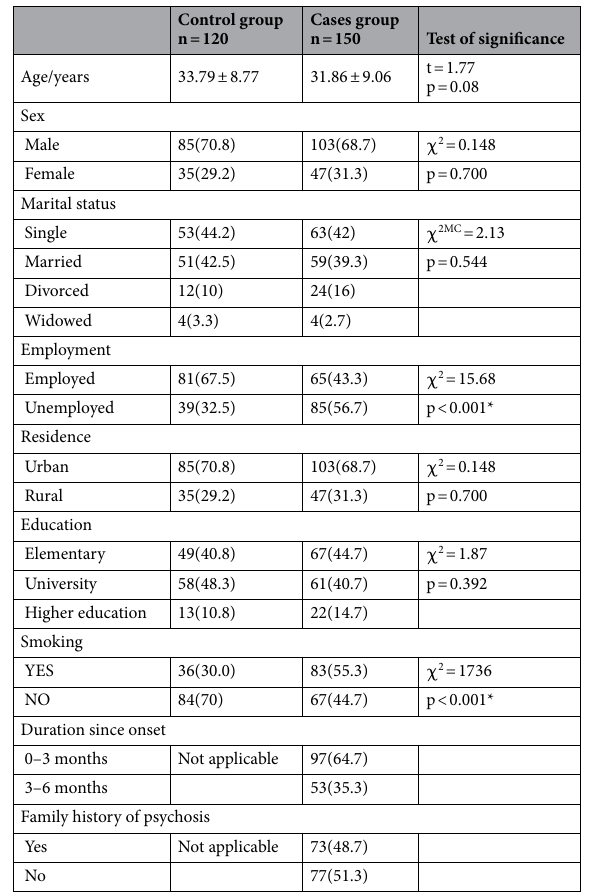
Table 1. Comparison of sociodemographic and clinical characteristics between studied groups. t: Student t test χ 2 = Chi-Square test, MC Monte Carlo test, *Statistically significant parameters described as mean ± SD, OR number and percentage.